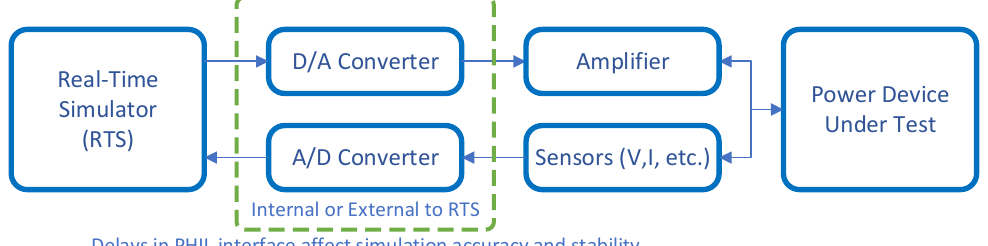
Figure 10. Interface (I/O) with external equipment can be internal or external, using a DAC from the RTS to the amplifier and an ADC from the device under test to the RTS.